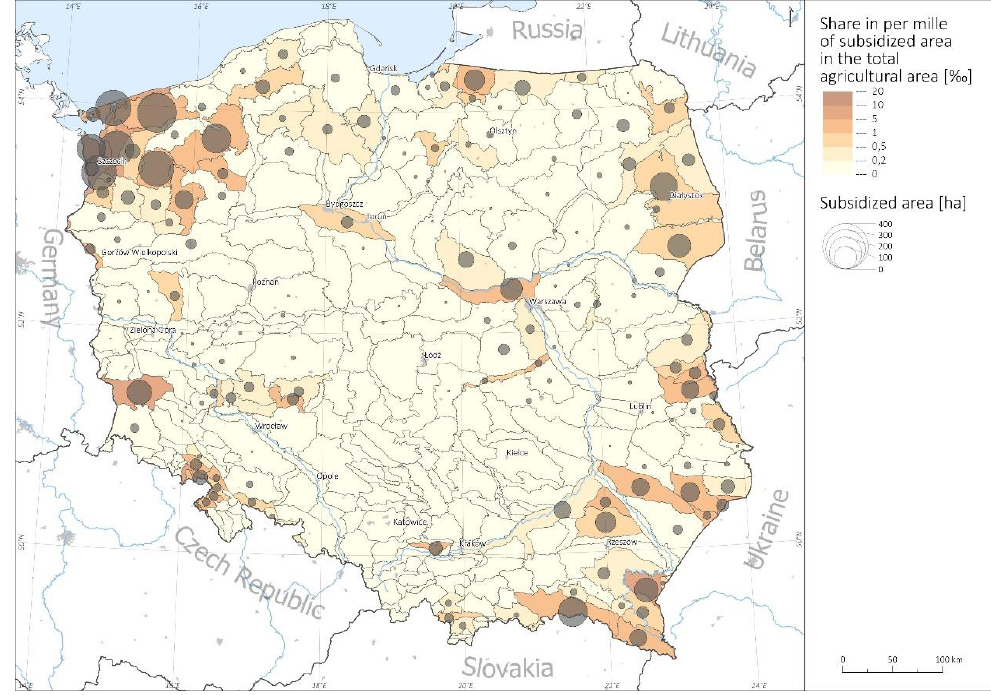
Figure 13. Area of land subsidised to support breeding habitats of corncrake and their share in the total agricultural area in mesoregions (Source: Authors based on ARMA data).